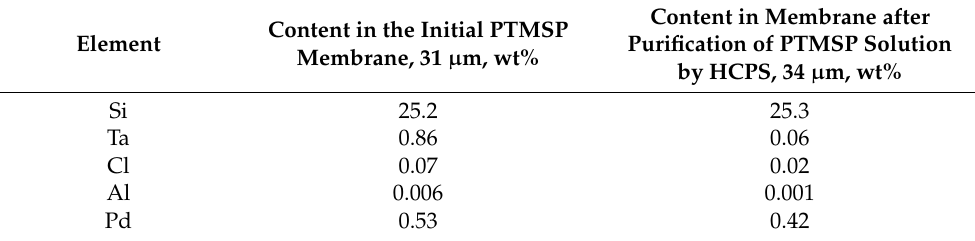
Table 2. The elemental composition of the initial PTMSP membrane, and the membrane produced after purification of PTMSP solution by